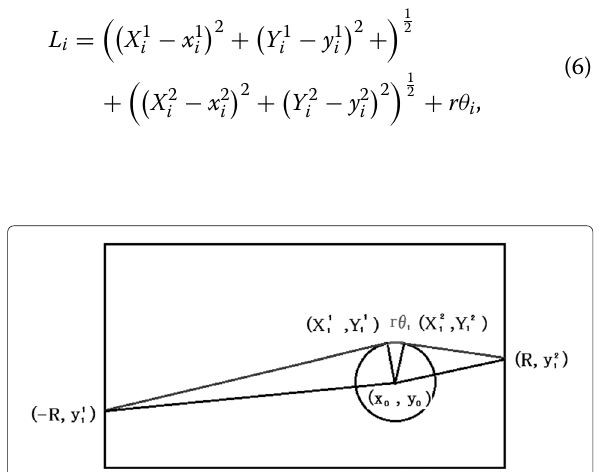
Fig. 8 Propagation of ultrasonic